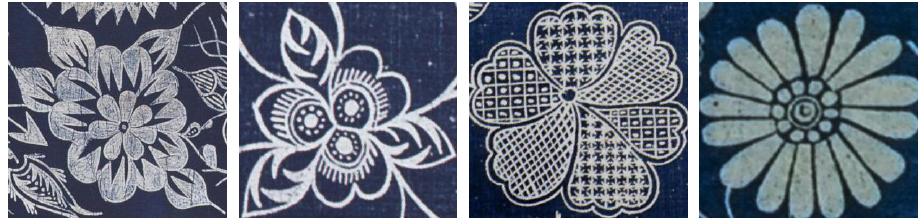
Figure 2. Batik flower